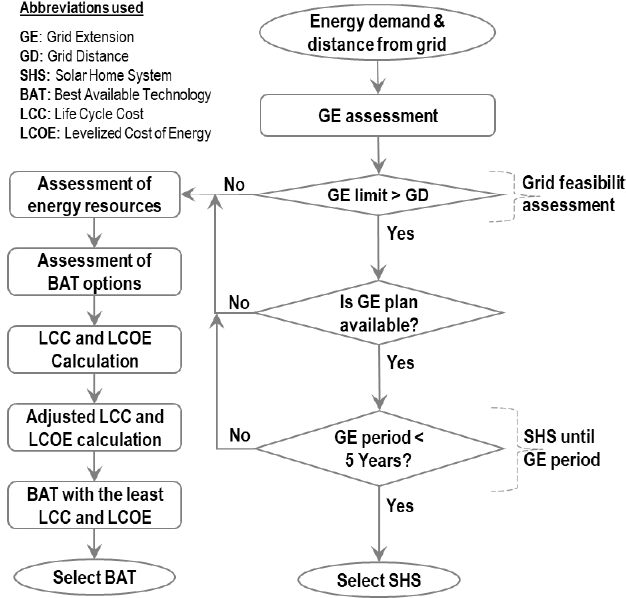
Figure 1. Modified decision tree from the AEPC.